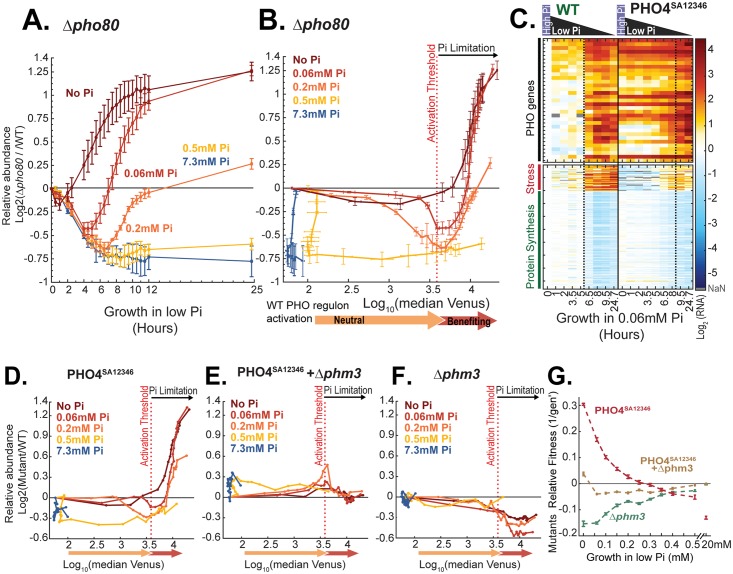
Constitutive activation of Pho4-target genes impacts cell growth.(A–D) Constitutive expression Pho4-dependent genes promote growth at low phosphate: Δpho80 cells and cells expressing the constitutive PHO4SA12346 allele were mixed with wild-type cells (either wild-type or mutant cells were mCherry labeled, respectively) and incubated in media containing different low-phosphate levels, as in Fig 2A. The (log2) relative abundance of Δpho80 cells in the mixture at different times following the incubation is shown in (A) as a function of time (see also S3D and S3E Fig for PHO4SA12346 and PHO4SA1234 cells). (B) and (D) depict the growth rate of Δpho80 and PHO4SA12346 cells as a function of reporter expression (PHO84p-Venus) in the wild-type cells, respectively. Note that, independently of the incubation conditions, the mutant cells begin to outcompete the wild-type cells when reporter activation in wild-type cells crosses the same threshold value at which wild-type cells become limiting for growth (Fig 1F), Δpho4 deleted cells begin to be outcompeted by wild-type cells (Fig 2C), and wild-type cells activate the second wave of Pho4-target gene expression (S1E Fig). The data in (A–B) are the mean and standard error of 3 replicates. (C) Temporal gene expression in cells expressing a constitutive Pho4 allele (PHO4SA12346), as in Fig 1C. Note that PHO4SA12346 strongly expresses the Pho4-target genes even in high Pi levels, which is consistent with previous reports [19]. The data in (C) are from 1 replicate, but see S3B and S3C Fig for related data showing equivalent behavior upon transfer into low Pi of 0.2 mM and 0.5 mM, respectively. (E–G) The growth phenotype of the Pho4-constitute strain depends on the mobilization of phosphate into storage: (E–F) same as (D), for the indicated strains. The data in (D–F) display 1 replicate; see (G) for additional supporting data. (G) The experiments in (D–F) were repeated using a variety of starvation media, and the fitness difference of mutant and wild-type cells was measured following approximately 24 hours incubation in low-Pi media. This fitness difference is shown as a function of the initial phosphate level in the starvation media. The data in (G) are the mean and standard error of 3 replicates. As described, Phm3 is a subunit of the vacuolar transporter chaperone complex, required for the storage of phosphate as polyP in the vacuoles. See S4E–S4I Fig for recovery of the above mutants from low Pi. The raw data for (A–B and D–F) are available in S4 Data. The raw data for (C) and (G) are available in S2 and S5 Data, respectively. NaN, not a number; Pi, inorganic phosphate; WT, wild type.